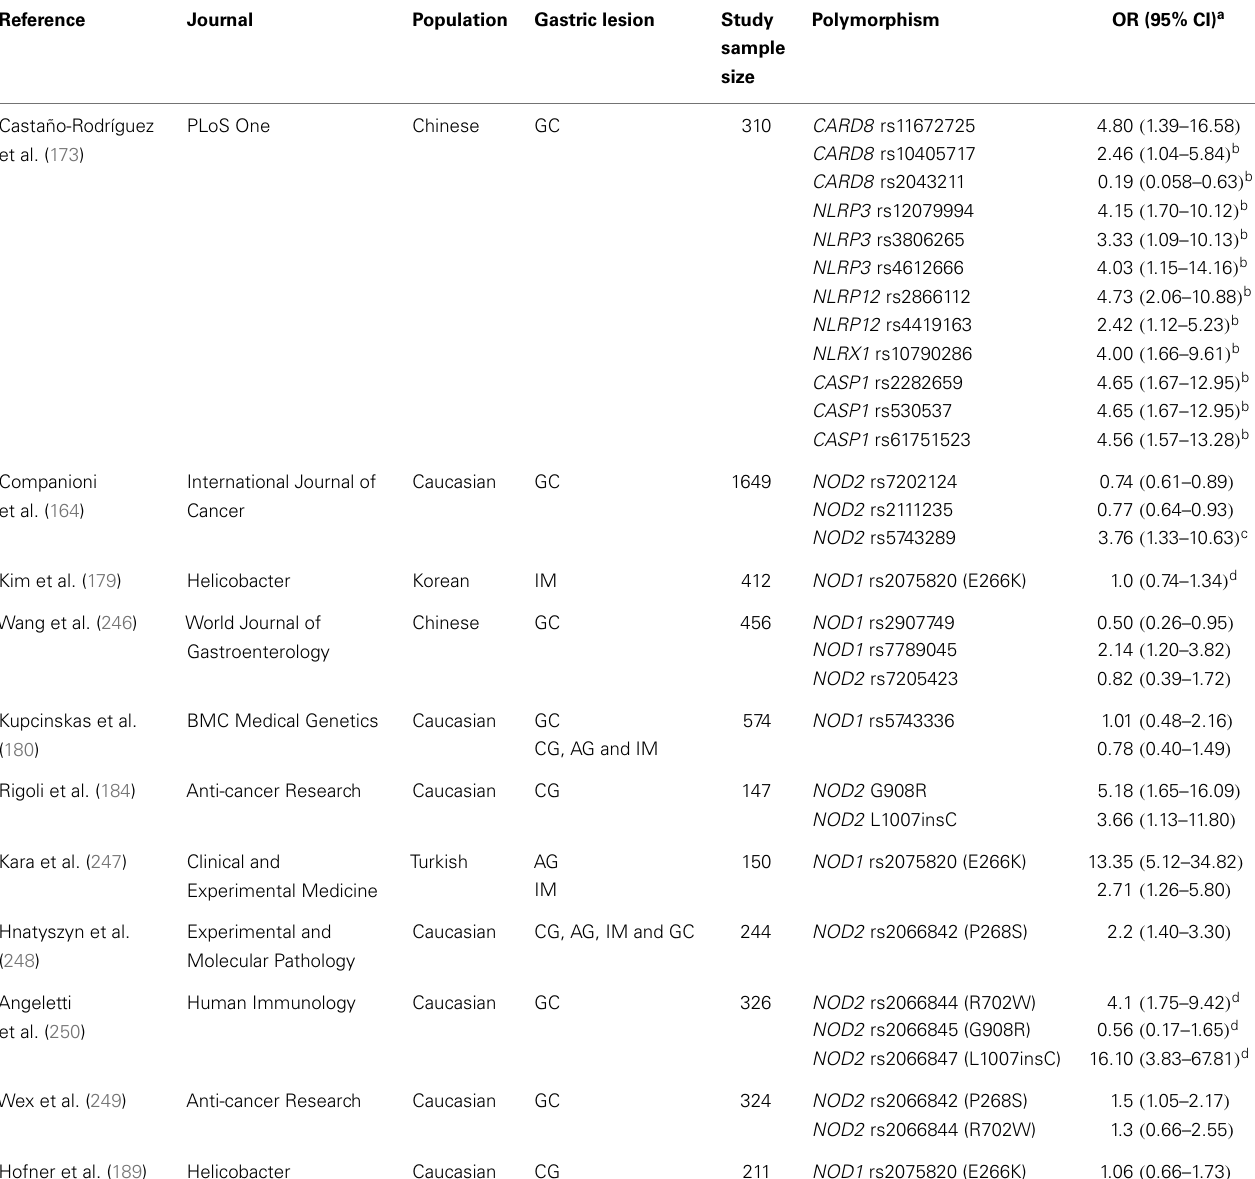
Table 3 | Genetic polymorphisms in the NOD-like receptor signalling pathway that have been studied in relation to gastric precancerous lesions and gastric cancer